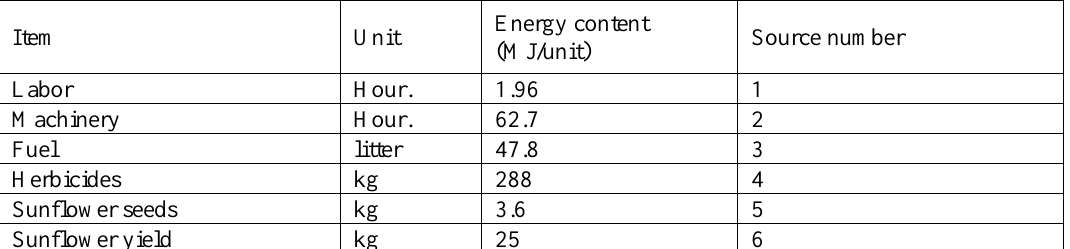
Table 1. Energy content for inputs and outputs of sunflower crop production